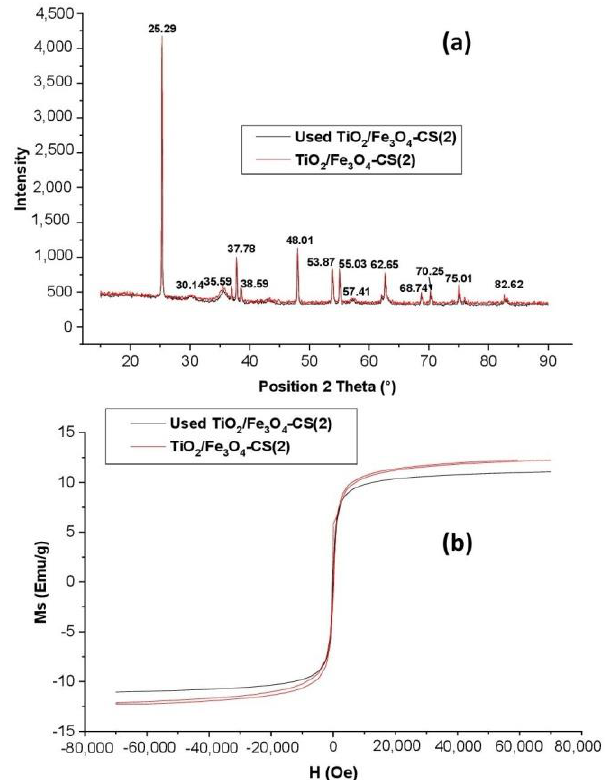
Figure 6. ( a ) X-ray diffraction patterns of TiO 2 /Fe 3 O 4 -CS(2) beads, ( b ) Magnetization curves of the fresh and used TiO 2 /Fe 3 O 4 -CS(2) beads.